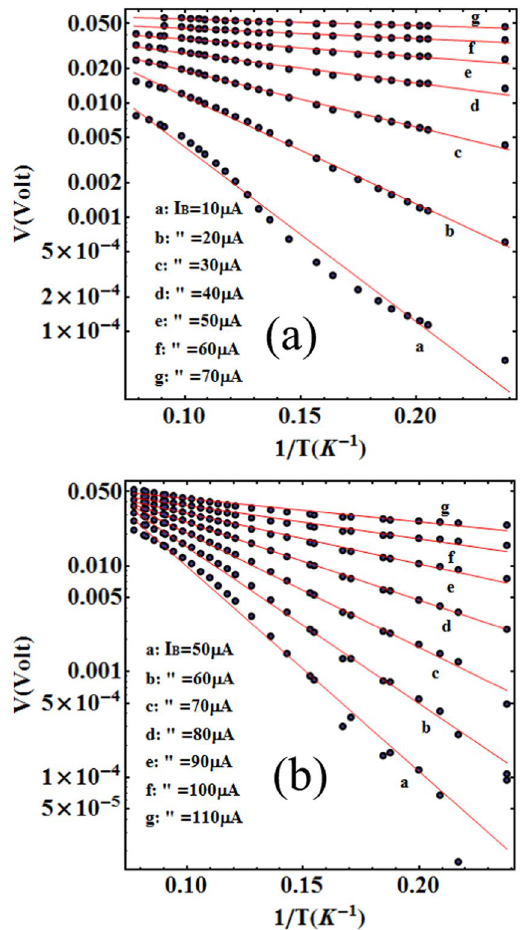
Figure 4. Inverse of the temperature dependence of the voltage when the sample (( a ), sample A and ( b ), sample B) is current-biased ( − V T log( ) 1/ relation) as obtained from data in Fig. 2. Almost linear dependence of ln( V ) on 1/ T is observed consistently with the theoretical flux creep model, equation (8) (red